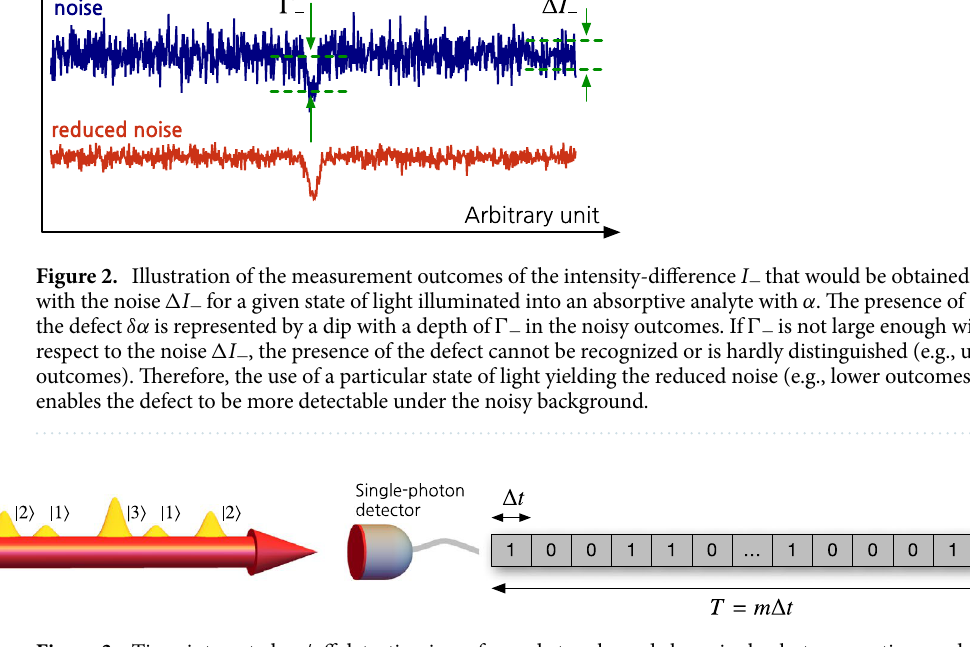
m (cid:31) t . The sequential measurement =